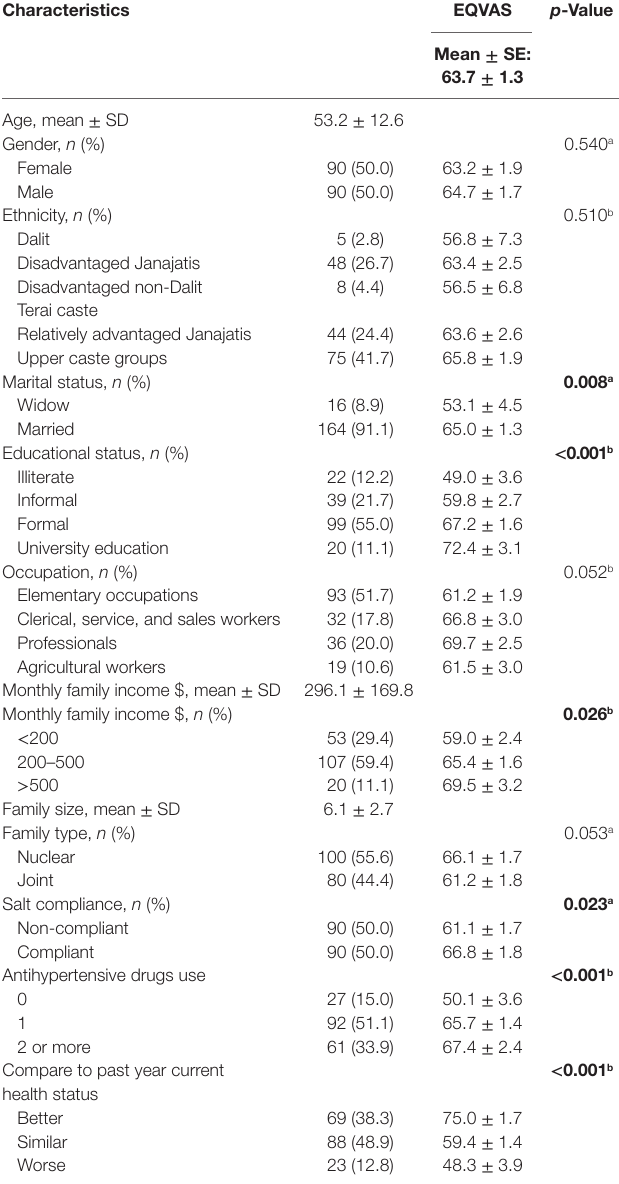
Table 2 | Factors associated with health-related quality of life of study participants.